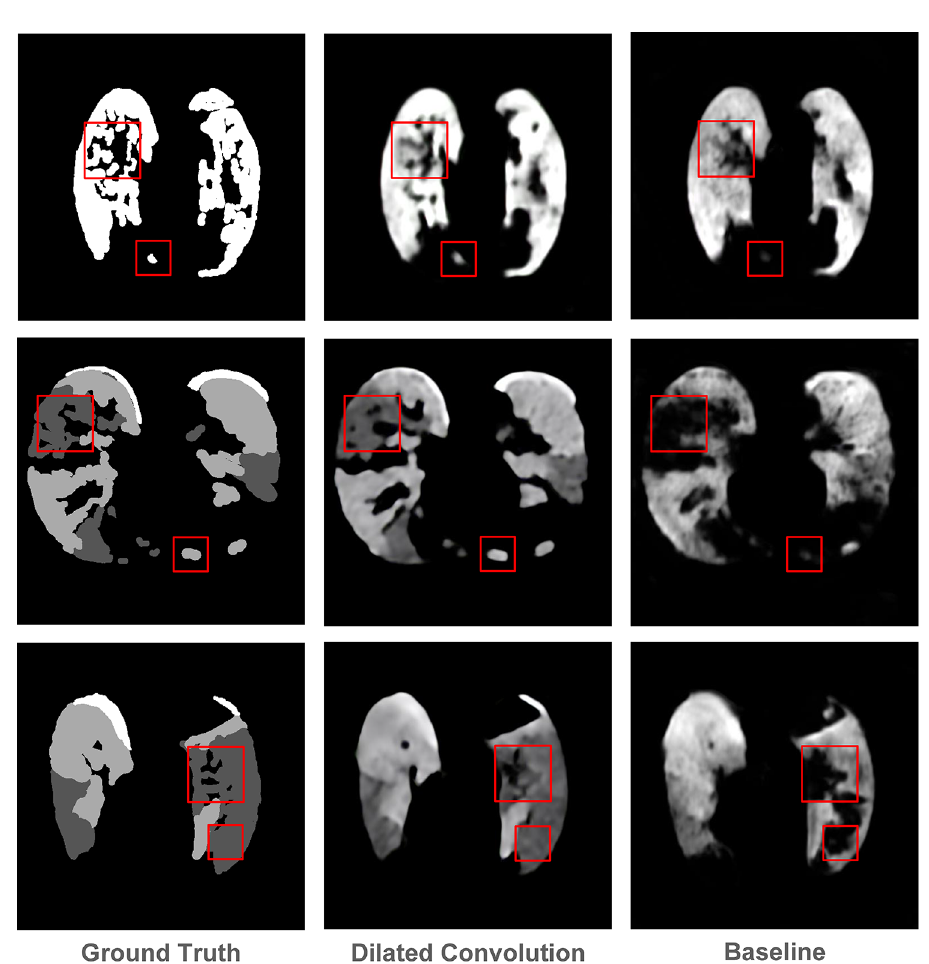
Figure 8. Lung infection segmentation results of different networks, where the ground-glass, consolidation, and pleural effusion are marked in dark gray, bright gray, and white, respectively. The first column is the ground truth. The second column is the segmentation result of the ResNet-50 network using dilated convolution. The last column is the segmentation result of the baseline based on